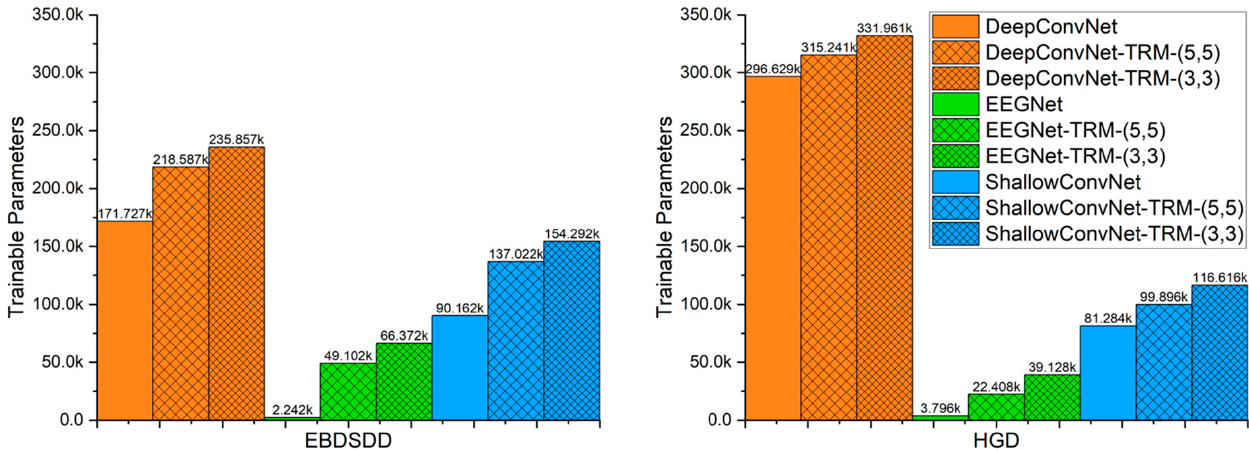
Figure 7. The numbers of trainable parameters for each algorithm. The left and right panels show the numbers of trainable parameters of the algorithms when used on the EBDSDD and HGD, respectively. Algorithms with “-TRM” use the TRM.